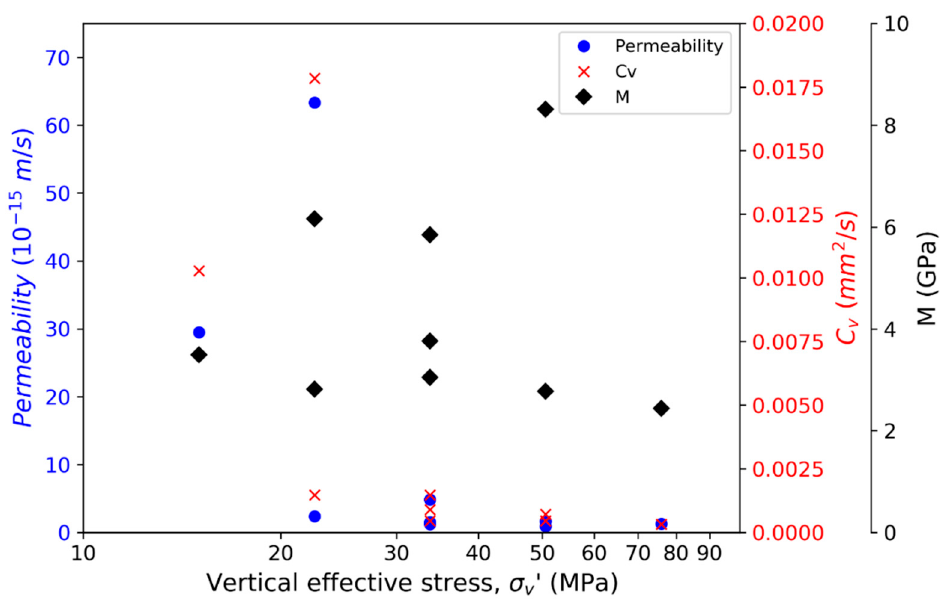
Figure 5. The measured coefficient of consolidation ( red ) and constrained modulus ( black ) and calculated hydraulic permeability ( blue ) versus vertical effective stress from incremental loading of Draupne shale in the oedometer.